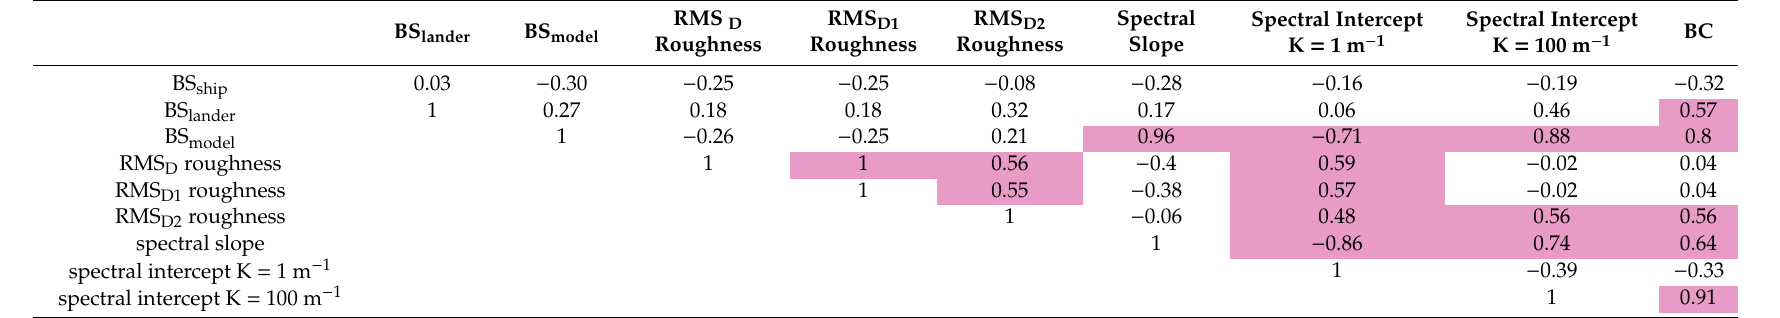
Table 1. Correlation matrix of the studied parameters. Entries highlighted show a probability value <<